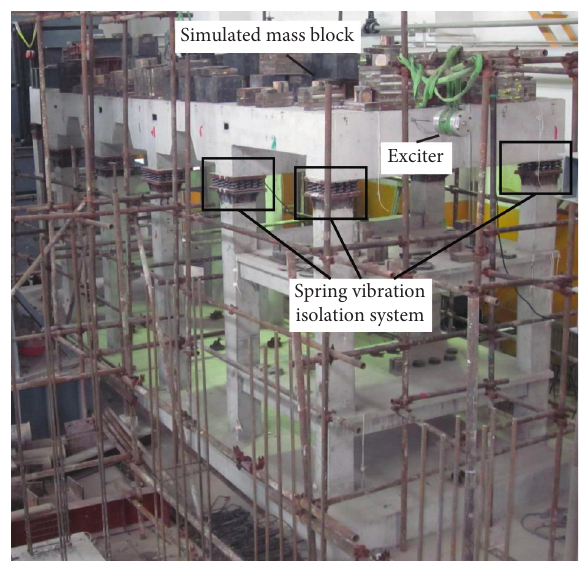
Figure 4: Photo of the experimental